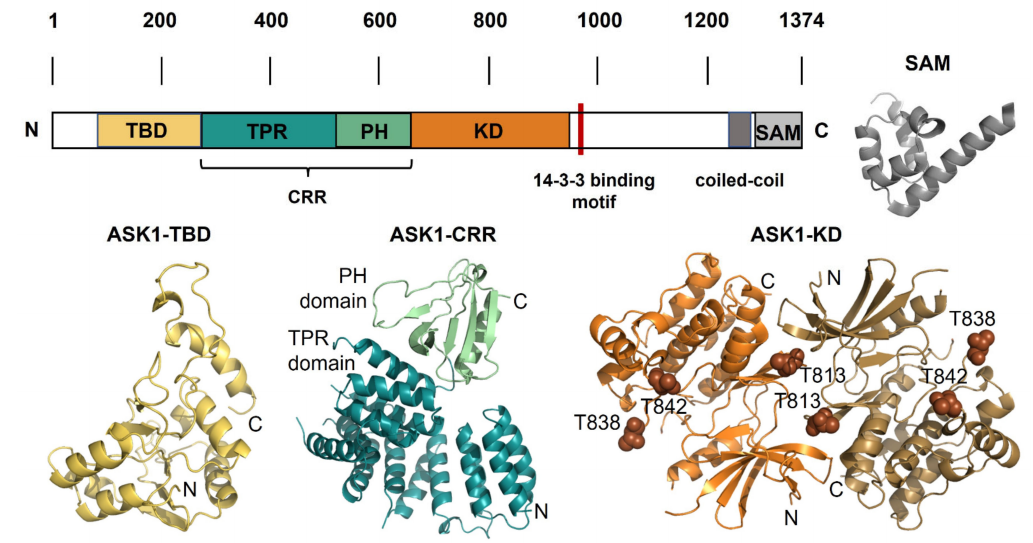
Figure 2. ASK1 and its structure. Schematic representation of the domain structure of ASK1 with the structural models of individual domains. TBD, thioredoxin-binding domain; TPR, tetratricopeptide repeat domain; PH, pleckstrin homology domain; CRR, central regulatory region; KD, kinase domain; SAM, sterile-alpha motif, the 14-3-3 site is shown in red. The structures of individual ASK1 domains: ASK1-TBD, the NMR-based structural model of thioredoxin-binding domain shown in yellow [29]; ASK1-CRR, the crystal structure of central regulatory region shown in teal and green (PDB ID: 5ULM [41]); ASK1-KD, the crystal structure of a dimer of kinase domain shown in orange and brown, and three autophosphorylation sites Thr 813 , Thr 838 and Thr 842 are shown as spheres (PDB ID: 2CLQ [42]); SAM, the crystal structure of SAM domain from ASK3 shown in grey (PDB ID: 6V0M